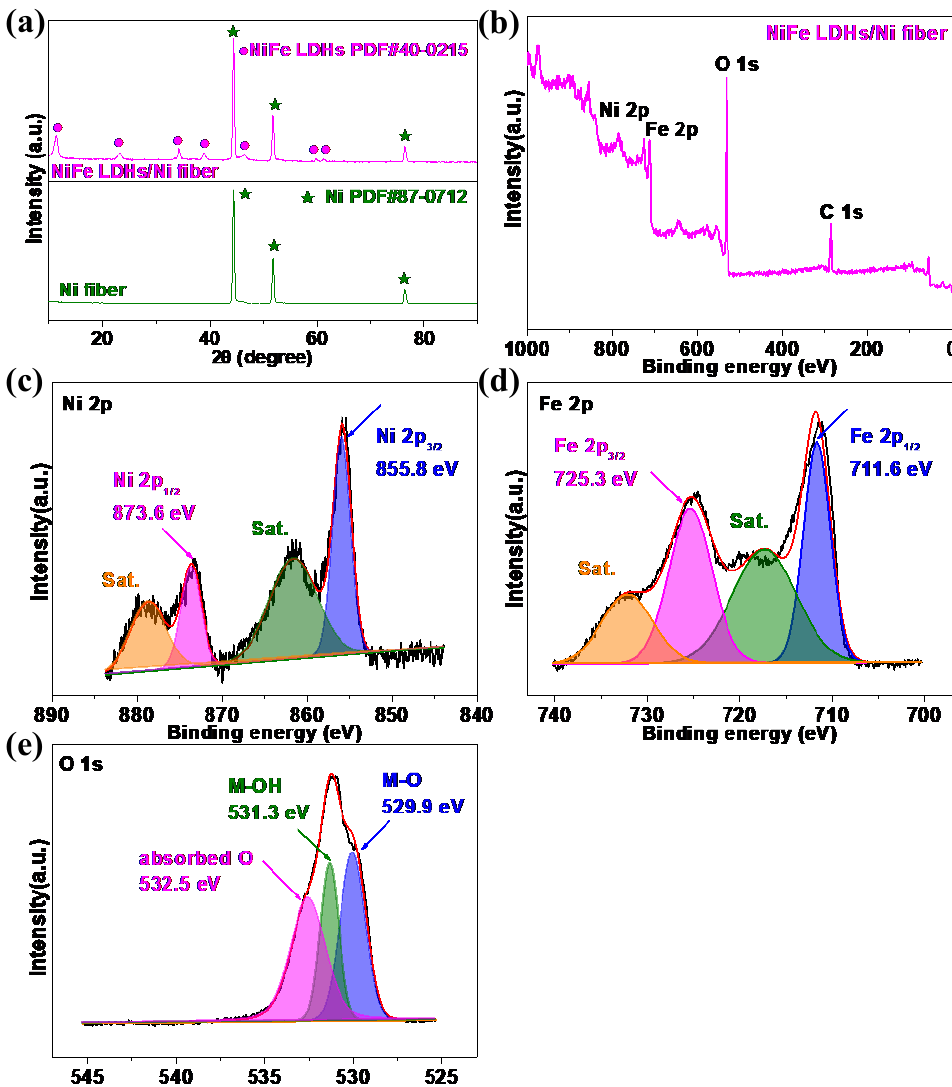
Figure 4. ( a ) XRD patterns of NiFe LDHs/Ni fiber electrode; ( b ) the NiFe LDHs/Ni fiber electrode XPS spectra of survey; ( c ) the NiFe LDHs/Ni fiber electrode of Ni 2p XPS spectra; ( d ) the NiFe LDHs/Ni fiber electrode of Fe 2p XPS spectra; ( e ) the NiFe LDHs/Ni fiber electrode of O 1 s XPS